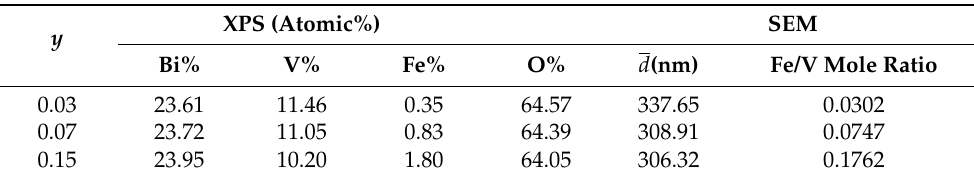
Table 2. Chemical analysis and microstructure characteristics of the as–prepared BiFeVOx.y photo- catalyst series.